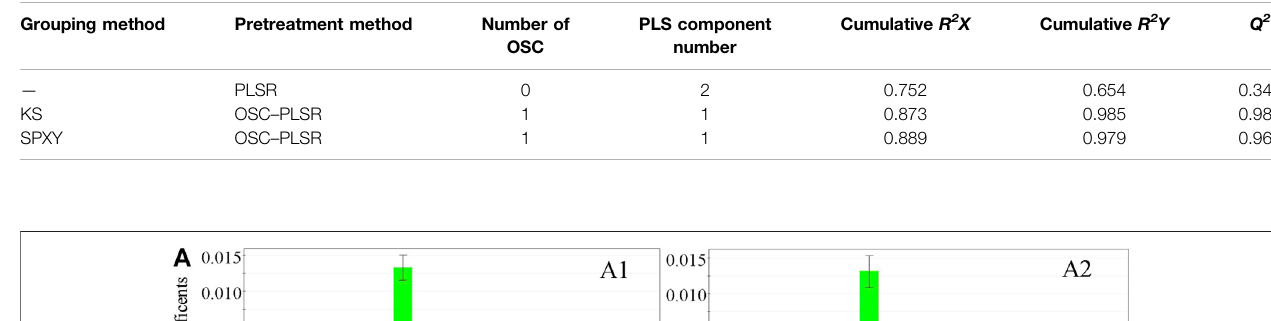
TABLE 2 | Optimized results of the PLS model.